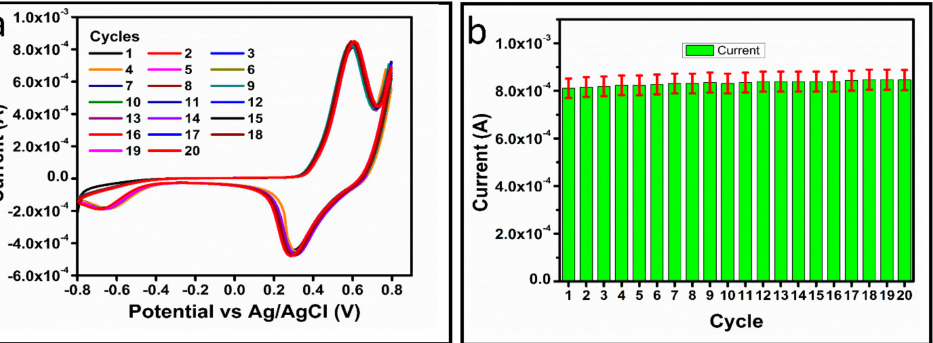
Figure 6. ( a ) CV curves of Sample 2 based on NiCo 2 O 4 nanomaterial for the monitoring of stability and repeatability, at 50 mV/s in the presence of 0.1 mM urea concentration prepared in 0.1 M NaOH, ( b ) illustration of peak current in bar graph for the statistical error for the demonstration of stability and repeatability of